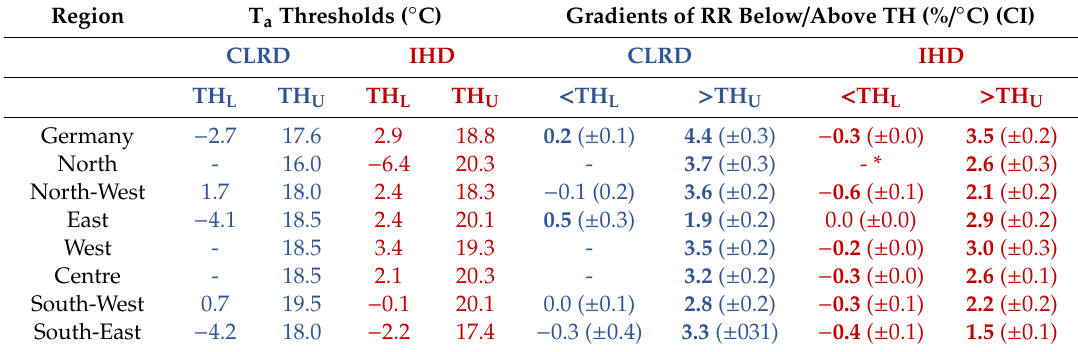
Table 2. Lower (TH L ) and upper (TH U ) threshold values of T a of CLRD mortality (blue) and IHD mortality (red), as well as the gradients of RR below resp. above these TH for Germany and its seven regions. Significant gradients on 95% level ( α = 0.05) are marked in